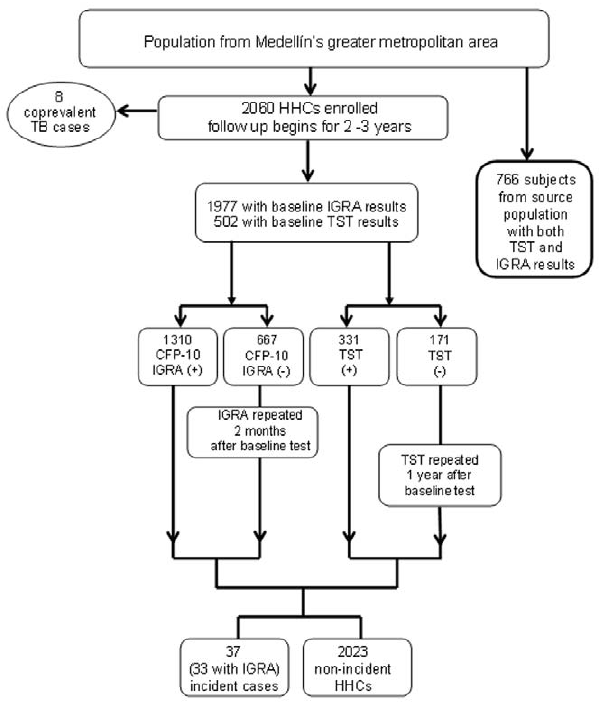
Figure 1. Study profile. HHCs=Household contacts, IGRA=IFN c Release Assay, TST=Tuberculin Skin Test, SP=source population, CFP- 10=Culture Filtrate Protein-10.